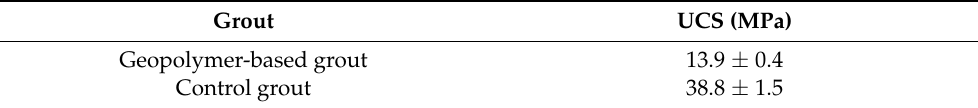
Table 4. Average UCS results for geopolymer-based and cement-based grouting mixtures.